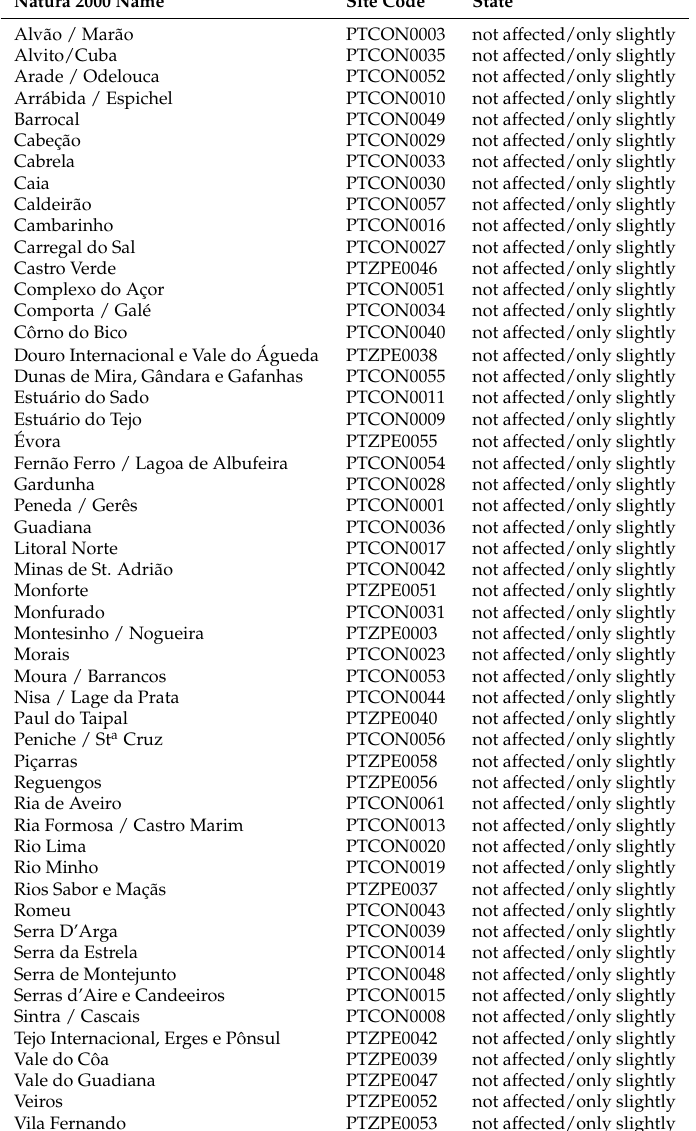
Table A4. Summary of the Natura 2000 sites that have been found not be affected or only